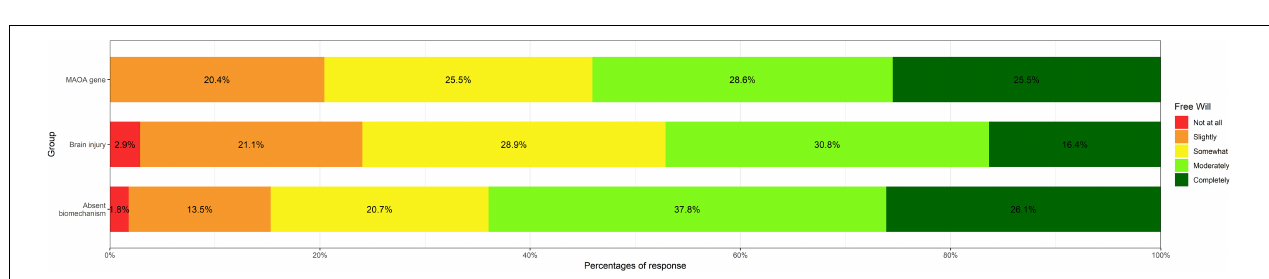
FIGURE 2 | Plot of proportional cross-tables (contingency tables) showing the response to the question how morally responsible the offender is.